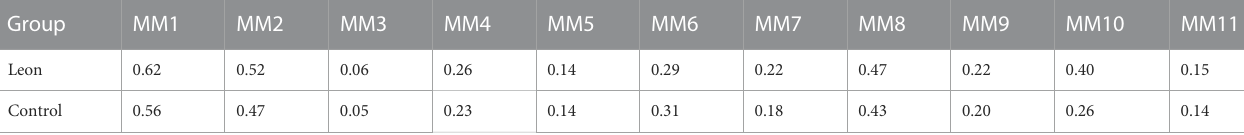
TABLE 8 The MFI of CD83 expression on moDCs (× 10 5 ) (MM patient-moDCs, n = 11).